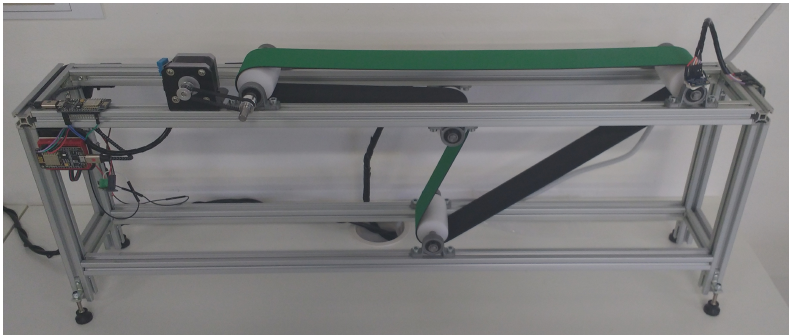
Figure 4. Prototype machine we used for experimental